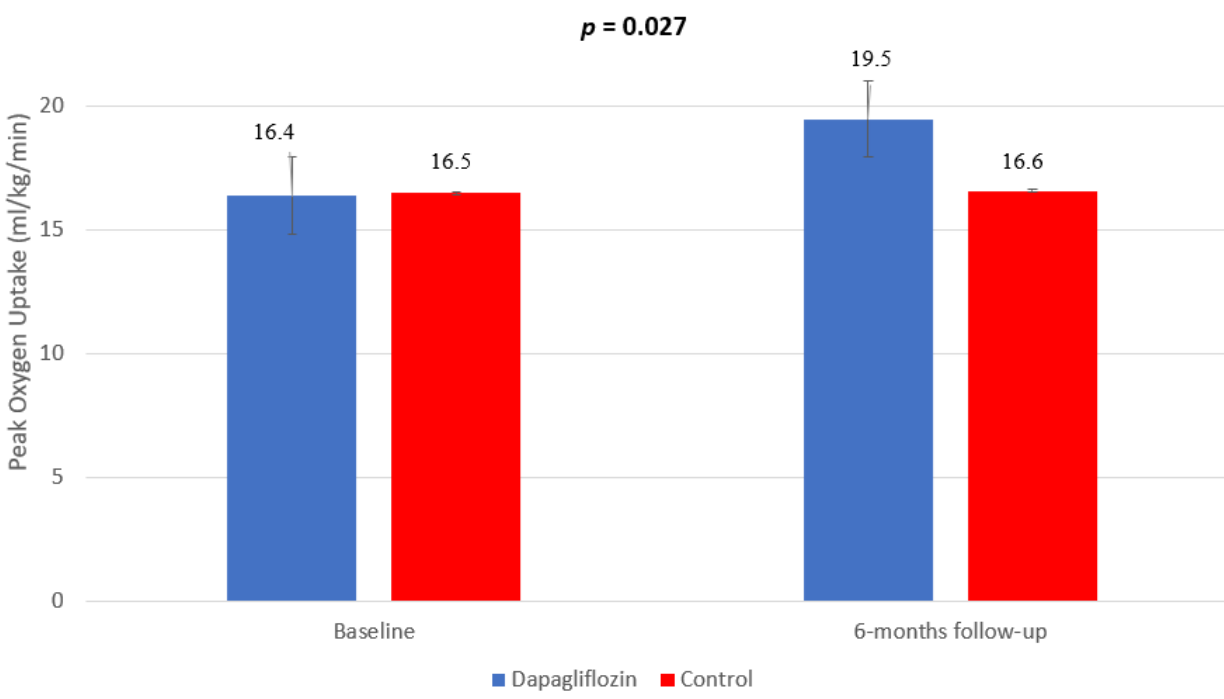
Figure 2. Primary endpoint—peak oxygen uptake variation from baseline to 6 months follow-up.